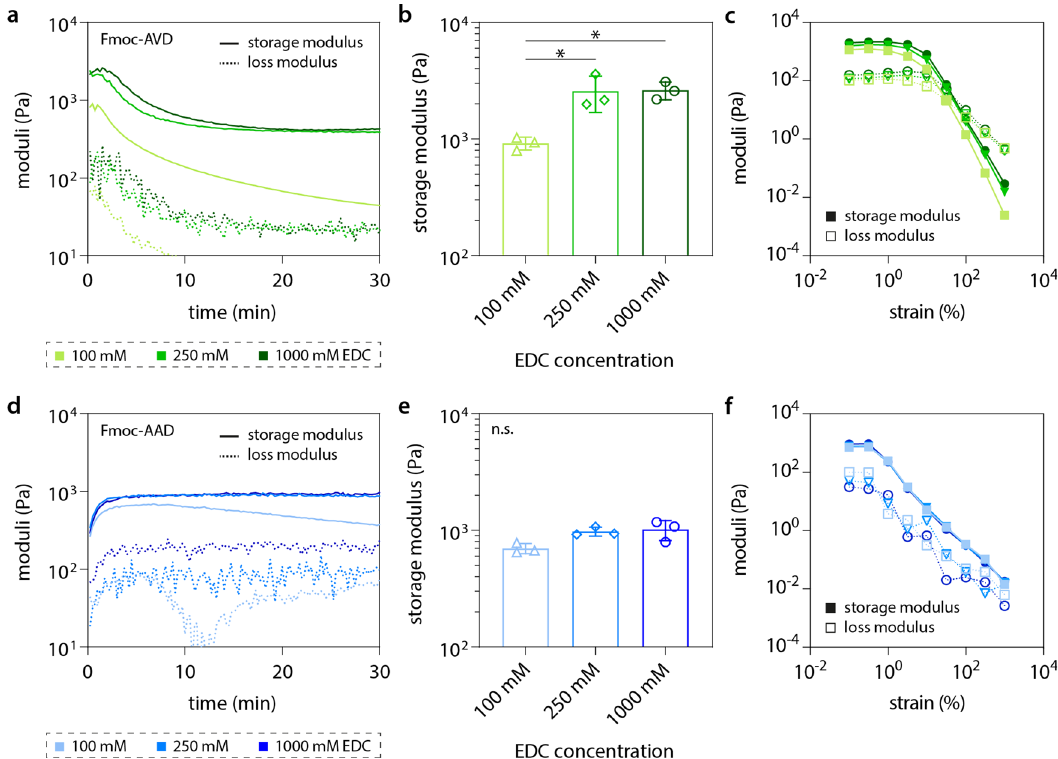
Fig. 2 Viscoelastic properties of self-assembled hydrogels. The fuel concentration affects the time-dependent viscoelastic properties ( a ), the maximal storage modulus obtained during the reaction process ( b ), and the nonlinear mechanical properties ( c ) of self-assembled Fmoc-AVD hydrogels. The Fmoc- AAD system is in fl uenced by different fuel concentrations in a similar manner ( d – f ); yet, the viscoelastic moduli stay in a plateau-like state once the gel is formed ( d ). Gelation curves ( a , d ) and LAOS measurements ( c , f ) show the mean of data obtained from n = 3 independent samples. Bar plots in panels ( b , e ) represent the mean together with the standard deviation ( n = 3, signi fi cance level p < 0.05 as determined by ordinary one-way ANOVA and Tukey post hoc tests). Fmoc-AVD data is depicted in green and Fmoc-AAD data is in blue. Bright colors represent an EDC concentration of 100 mM, medium bright colors correspond to 250 mM, and dark colors to 1000 mM. Solid lines represent the storage modulus and dashed lines the loss modulus. Individual data points are depicted with triangles (100 mM EDC), rhombuses (250 mM EDC), and circles (1000